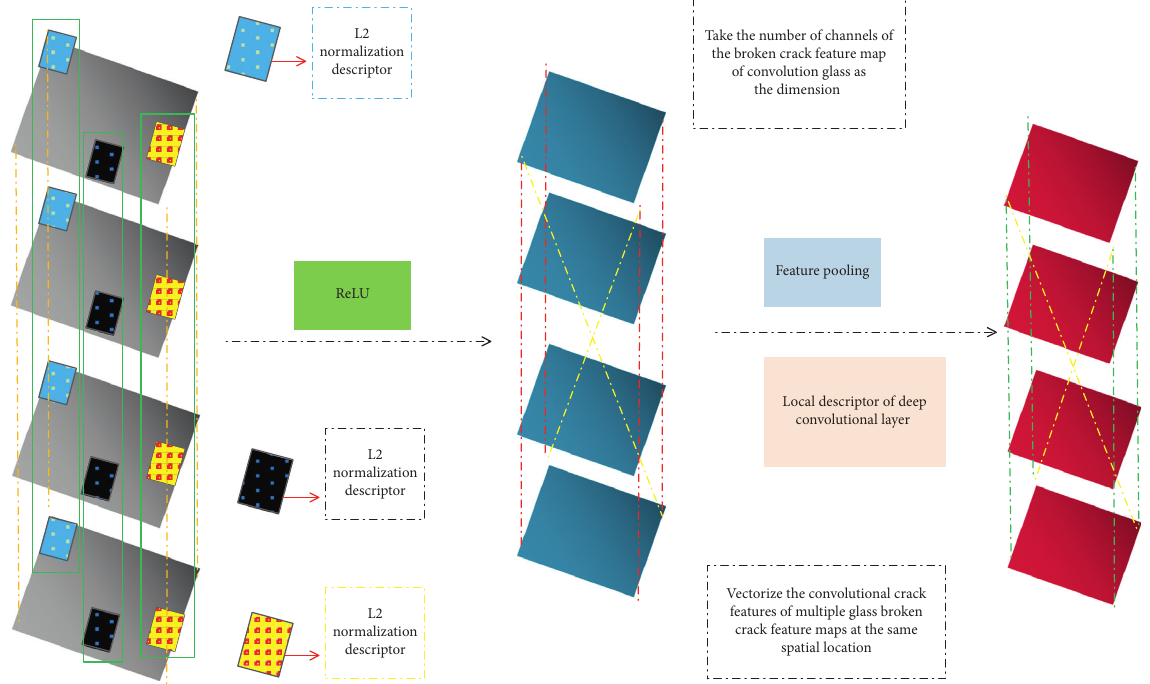
Figure 4: Descriptor extraction of the last convolutional layer of